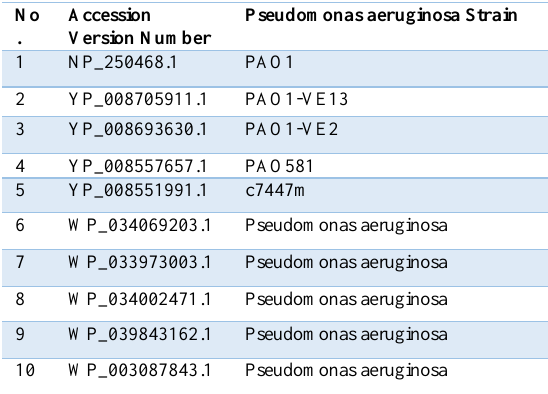
Table1. Information About the Reference Strains of Pseudomonas